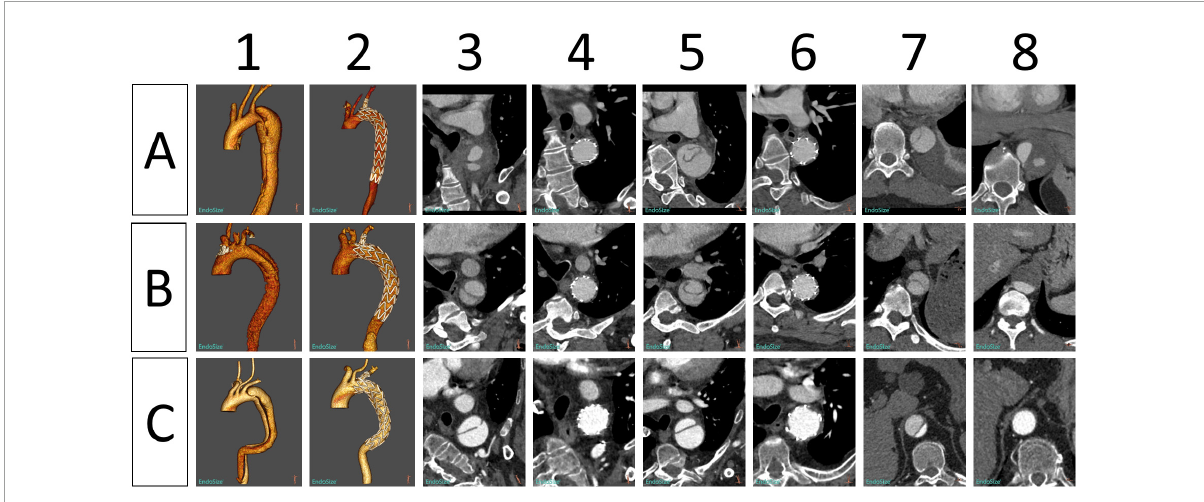
FIGURE5 Morphological changes in the aorta in three patients (A–C) before and after implantation of Castor single-branched stent grafts. (1, 2) Preoperative and postoperative 3D reconstruction of the thoracic aorta. (3, 4) Preoperative and postoperative images of the aortic isthmus. (5, 6) Preoperative and postoperative images at the level of the pulmonary artery bifurcation. (7, 8) Preoperative and postoperative images of the aorta at the level of the